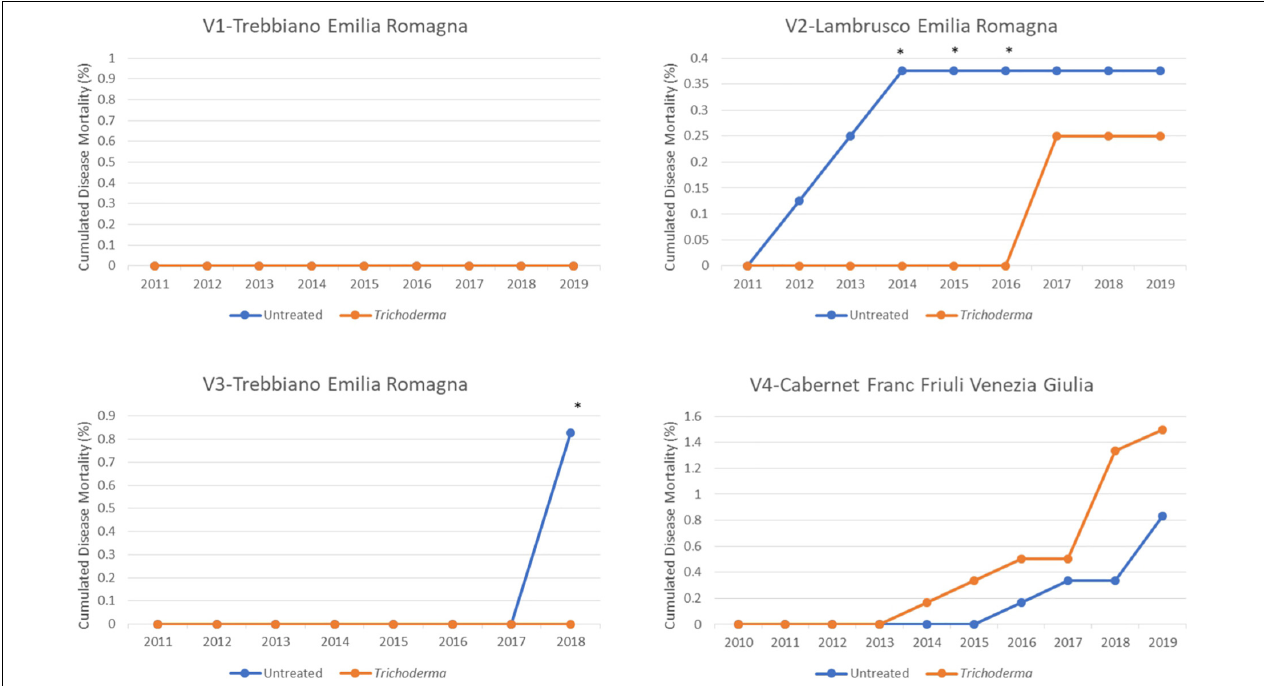
FIGURE 7 | Cumulated mortality in the four young asymptomatic vineyards after 8–10 years of survey was analyzed by χ 2 test. All the plants of each plot were considered to compare Trichoderma and control treatments. Where differences in distribution between the two treatments were significant, an asterisk was placed ( P < 0.05).